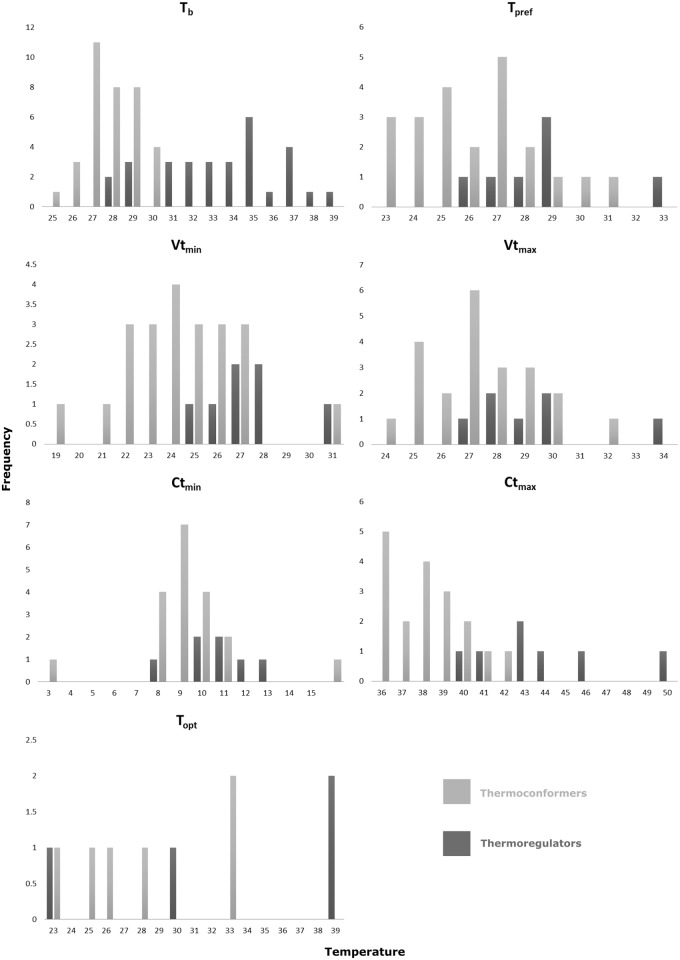
Temperature frequency distribution by thermal regulation mode for each thermal trait evaluated.Species were classified a priori as thermoregulators or thermoconformers. Values of temperature (x-axis) correspond to the mean value for each species.